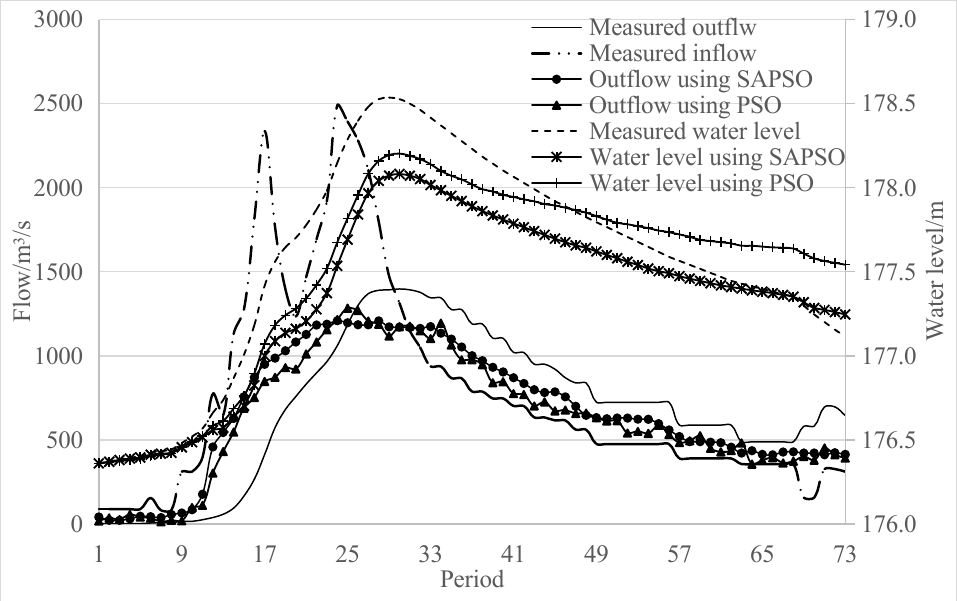
Figure 5. Operation hydrographs of Tianzhuang Reservoir for the 13 August 1974 flood.